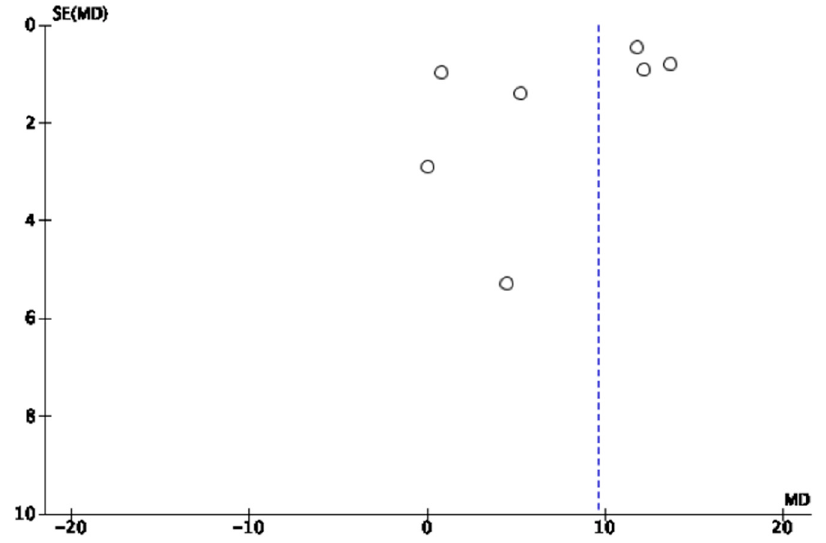
Figure 5. Funnel plot for animal studies. The asymmetry proves publication